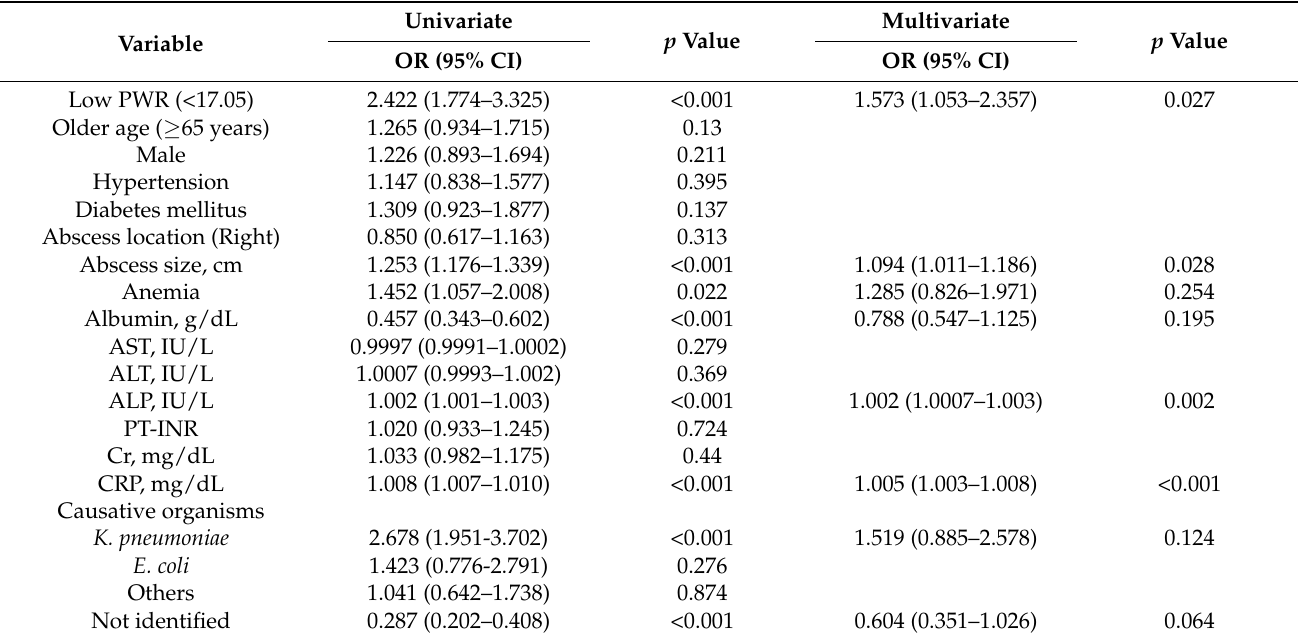
Table 5. Risk factors for prolonged hospitalization for more than 14 days in patients with pyogenic liver abscesses.